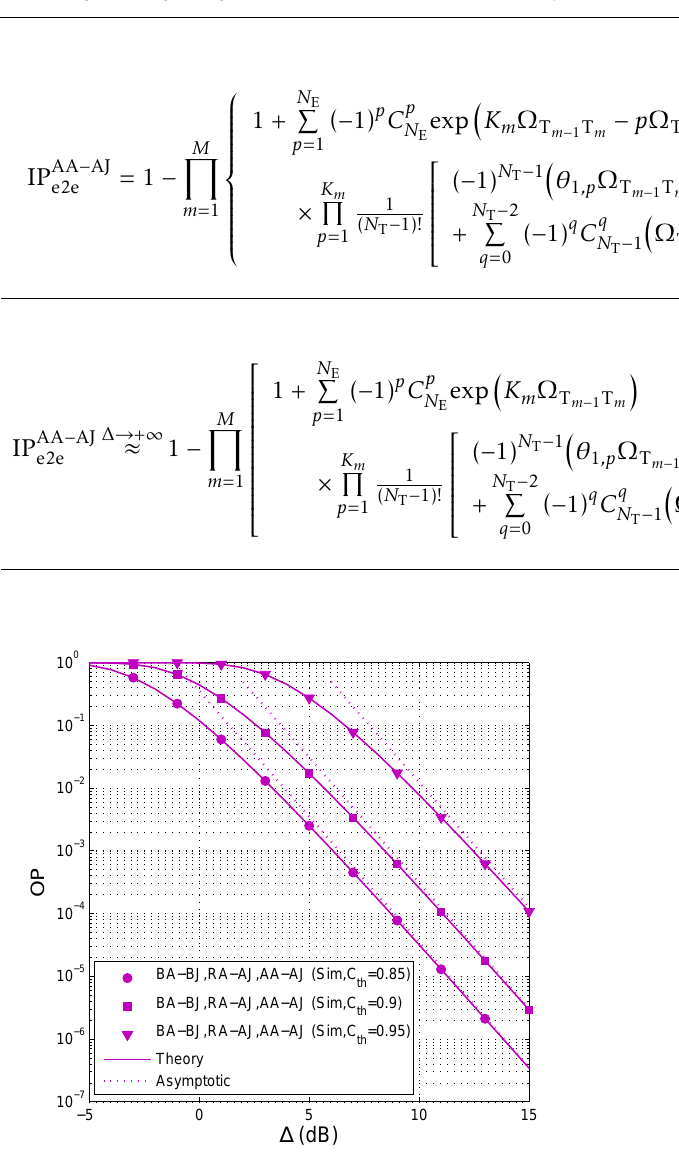
Figure 2. OP as a function of ∆ (dB) when M = 4 , N K = 4 , α = 0 . 1 and µ 2